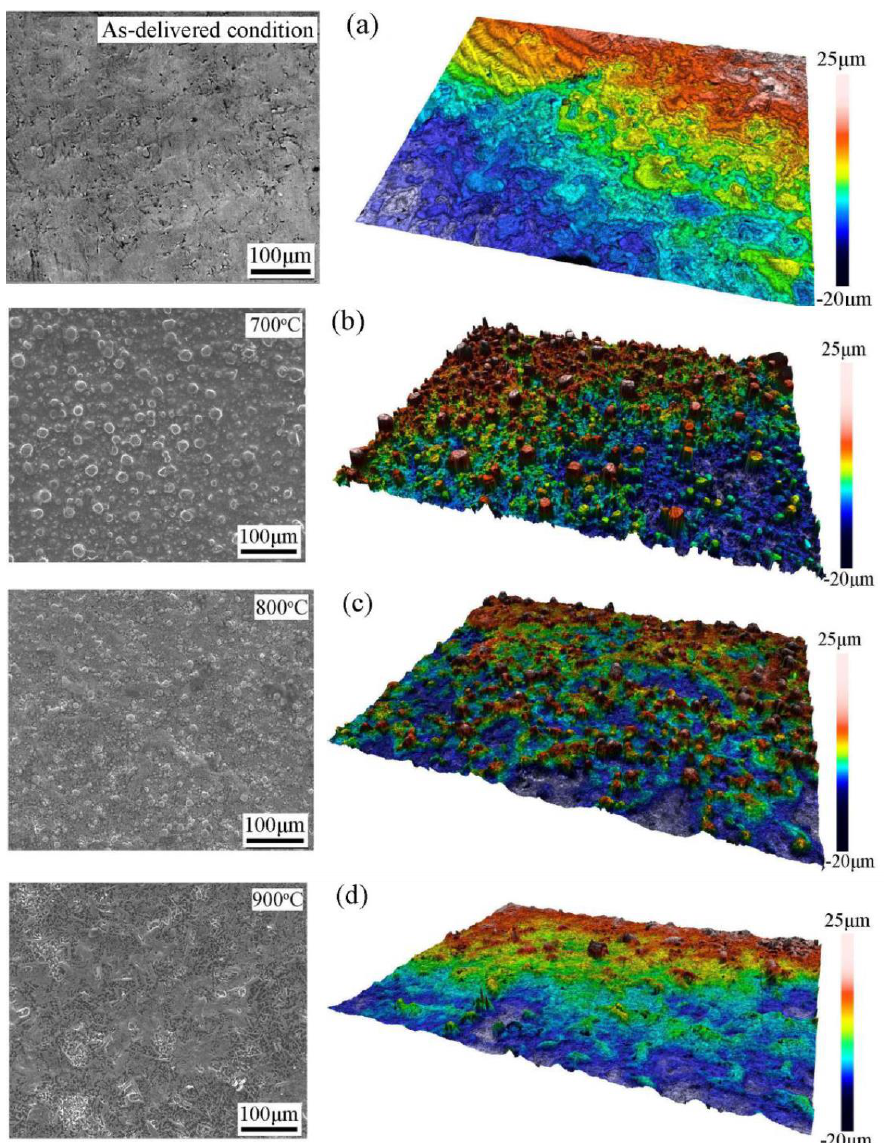
Figure 4. Scanning electron microscopy (SEM) images and 3D profiler maps of the coating surface heated at different temperatures: ( a ) as-delivered condition, ( b ) 700 °C, ( c ) 800 °C, and ( d ) 900 °C.